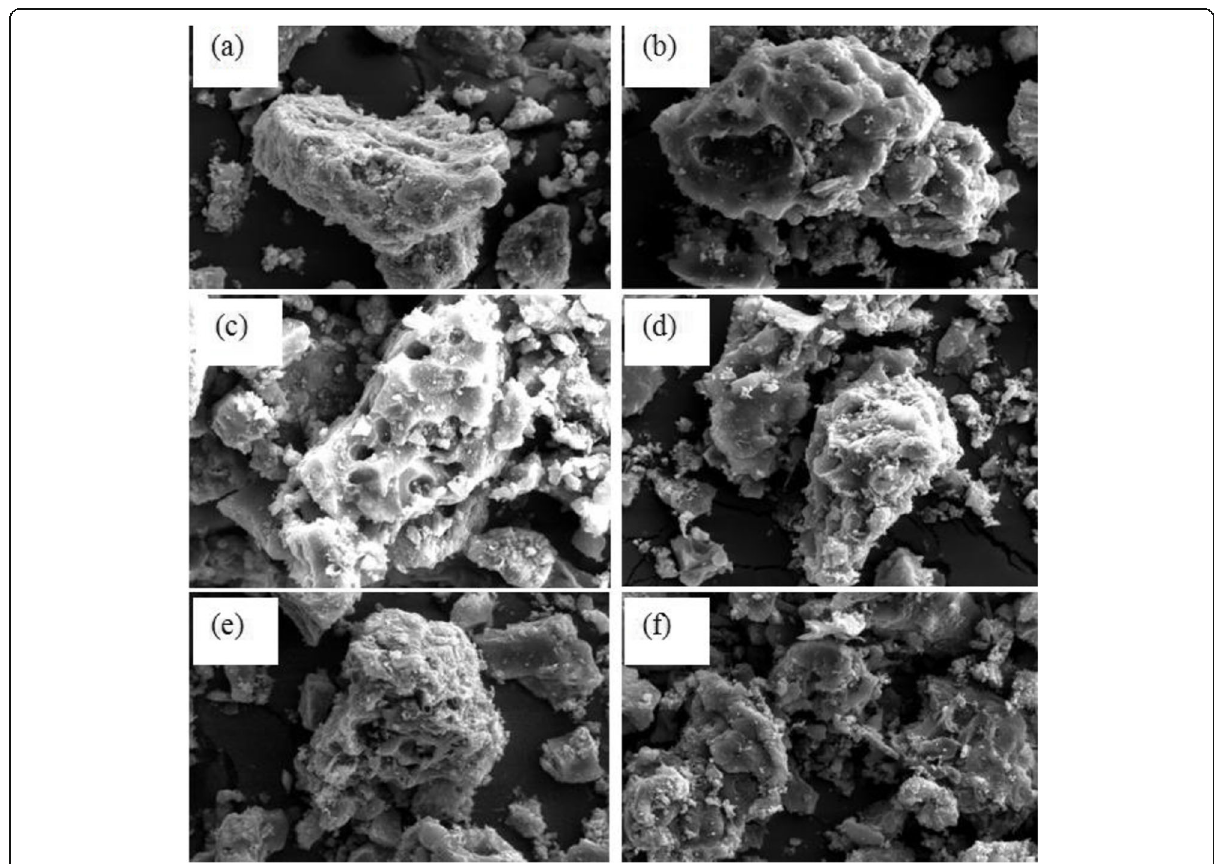
Fig. 1 SEM micrograph of SBC at different temperatures: ( a ) 300 °C, ( b ) 400 °C, ( c ) 500 °C ( d ) 600 °C, ( e ) 700 °C and ( f ) 800 °C